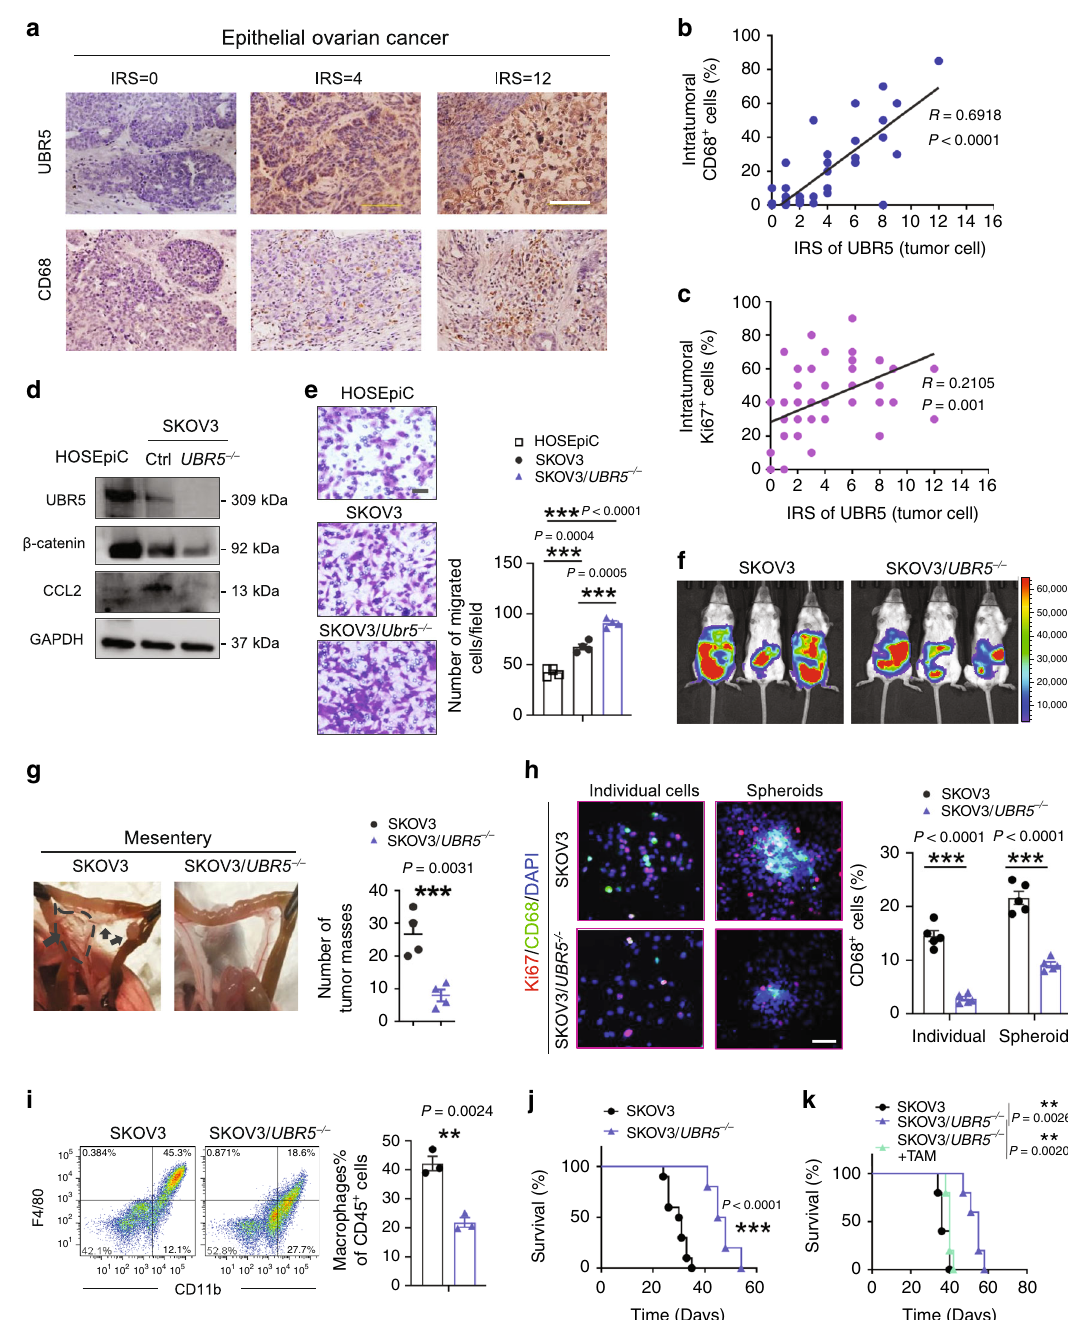
Fig. 7 Effects of human OC-derived UBR5 on TAMs and tumor growth. a IHC staining of UBR5 and CD68 in primary tumors from OC patients ( n = 50 samples). Scale bars: 200 μ m. b , c Correlation assessed by Pearson correlation analysis and linear regression analysis between tumor UBR5 expression levels and intratumoral CD68 + ( b ), Ki67 + cell density ( c ) in human EOC patients ( n = 50 samples). d Deletion of UBR5 in SKOV3 cells was veri fi ed by western blot. Reduced β -catenin and CCL2 expression in SKOV3/ UBR5 − / − were determined at protein level, human ovarian surface epithelial cells HOSEpiC were used as control. e Representative micrographs and quantitation of Transwell-migration assay for SKOV3 ( n = 4 biologically independent samples per group and an average of fi ve fi elds acquired from each sample). Scale bars: 50 μ m. f On day 21 after tumor implantation, imaging with Luciferase in SKOV3 tumor bearing SCID/Beige mice ( n = 3 mice per group). g Representative images and statistical analysis of tumor implantation in mesentery ( n = 4 mice per group). h Representative images of CD68 + macrophages and surrounded Ki67 + cells from peritoneal washes ( n = 4 mice per group and ten confocal images acquired from each sample). All panels are the same magni fi cation, scale bars: 50 μ m. i Representative FACS images and quanti fi cation of in fi ltrated CD11b + F4/80 + macrophages in peritoneal cavity ( n = 3 mice per group). j Kaplan – Meier curves showing the survival of SKOV3 tumor-bearing mice ( n = 10 mice per group). P < 0.0001, log-rank test. k Survival in mice bearing SKOV3/ UBR5 − / − with or without TAMs isolated from SKOV3 bearing donor mice were quanti fi ed ( n = 5 mice per group), log-rank test. In all cases, data are representative of two independent experiments. Data are presented as mean ± SEM, unpaired two-sided Student ’ s t -test with no correction for multiple comparison, ** P < 0.01, *** P < 0.001. Source data are provided as a Source Data fi